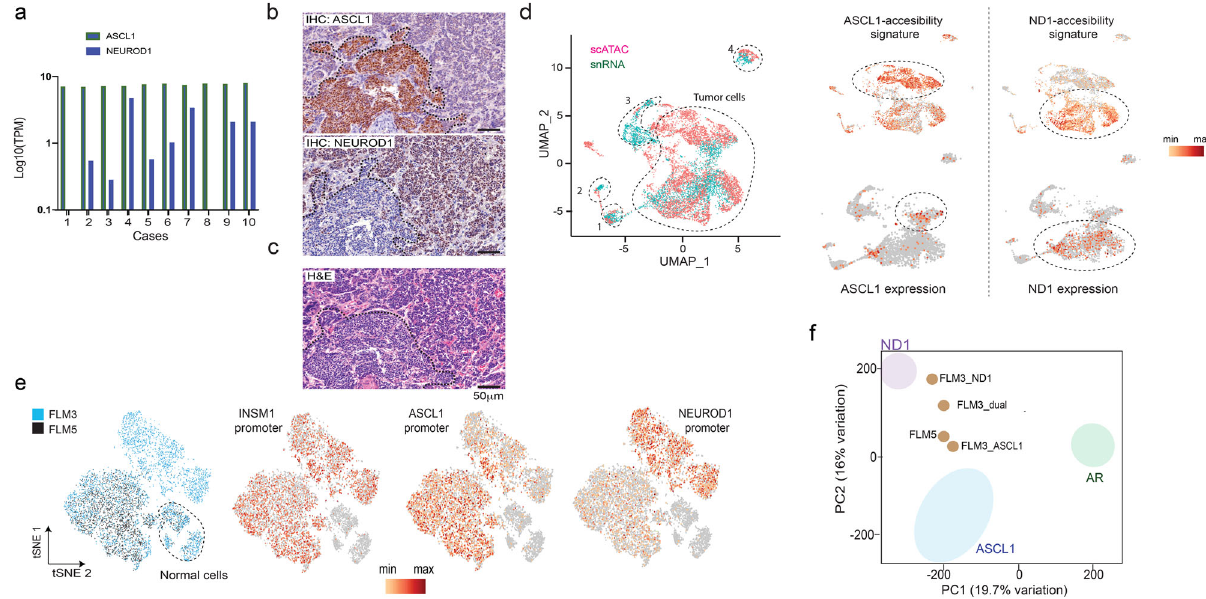
Fig. 3 Single-cell analysis reveals that NEPC subtypes co-exist in human metastasis and contribute to inter- and intra-tumoral heterogeneity. a Plot of ASCL1 and NEUROD1 expression in NEPC tissues from a clinical cohort 16 . TPM: transcripts per million. b Representative immunostaining of FLM3 (ASCL1 staining in the top panel and NEUROD1 staining in the middle panel) showing intratumor heterogeneity. c Hematoxylin and eosin staining of the same fi eld illustrates the distinct histologies for the two subpopulations. d Combined analysis of the scATAC-seq and snRNA-seq in FLM3 (left). Markers speci fi c for normal cell populations enabled assignment of clusters: 1, vascular cells; 2, stromal cells; 3, hepatic cells; 4, monocytes. Accessibility at the top 30 differential ATAC-seq regions between ASCL1 and NEUROD1 subtypes identi fi ed by bulk analysis (top right). Analysis of ASCL1 and NEUROD1 expression in the snRNA-seq analysis (bottom right). This analysis matches cells with TF expression and the corresponding differential DNA accessibility for each subtype. e tSNE analysis of the combined FLM3 (blue) and FLM5 (black) scATAC-seq data (left). The other three plots show accessibility at INSM1 promoter (NE marker) and the differential accessibility at ASCL1 promoter and NEUROD1 promoter. f Projection of the aggregated scATAC-seq clusters for FLM3 and 5 (light brown dots) within the PCA space de fi ned in Fig. 2a. Source data are provided as a Source Data fi